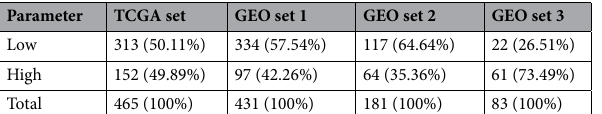
Table 1. The baseline characteristics of lung adenocarcinoma patients in this study. TCGA The Cancer Genome Altas, GEO Gene Expression Omnibus, NA represents information not available.